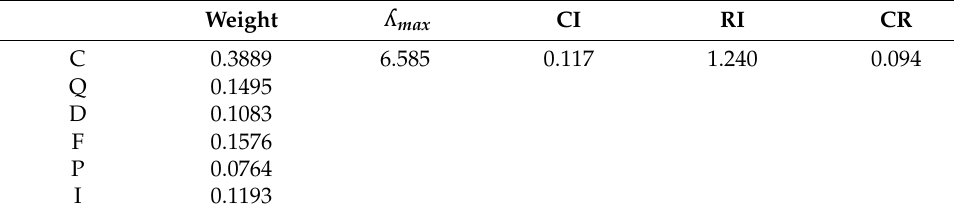
Table 5. Criteria weights and related parameter values. Weight